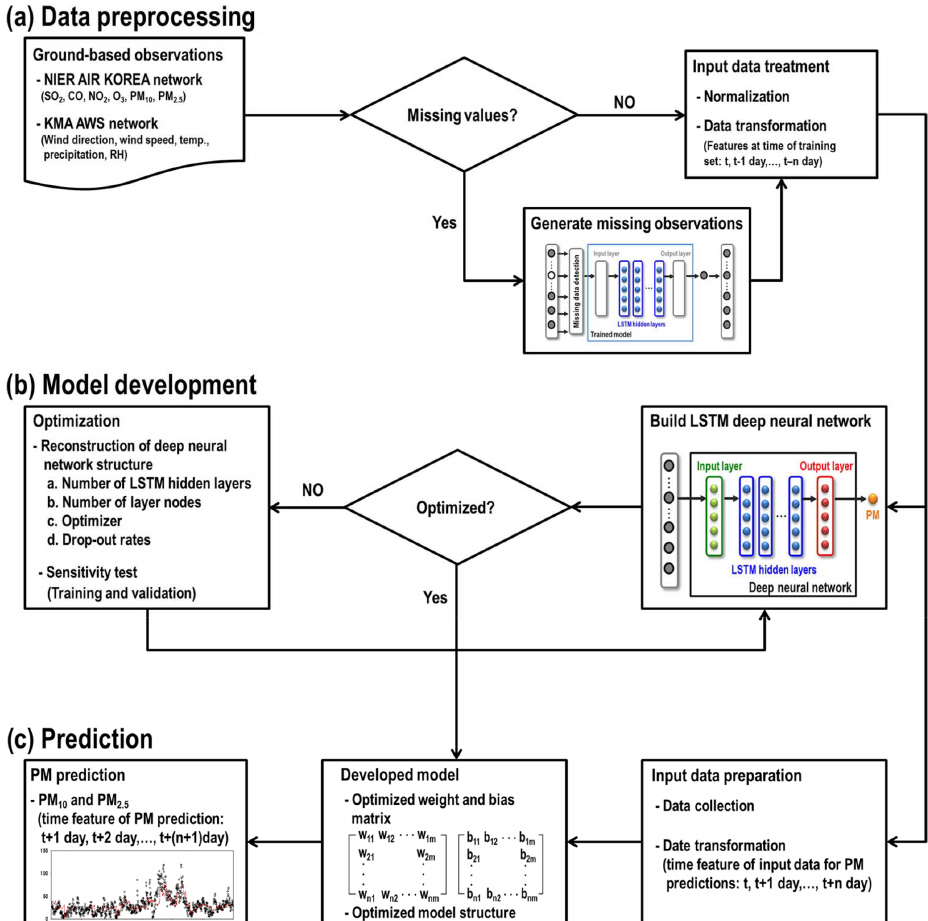
Figure 1. Schematic diagram of how the LSTM-based PM 10 and PM 2 . 5 prediction system was